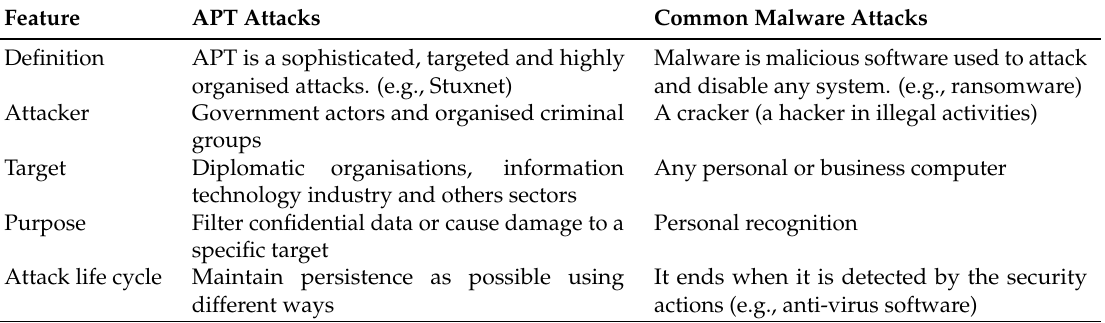
Table 1. Differences between an advanced persistent threat (APT) attack and common malware attacks